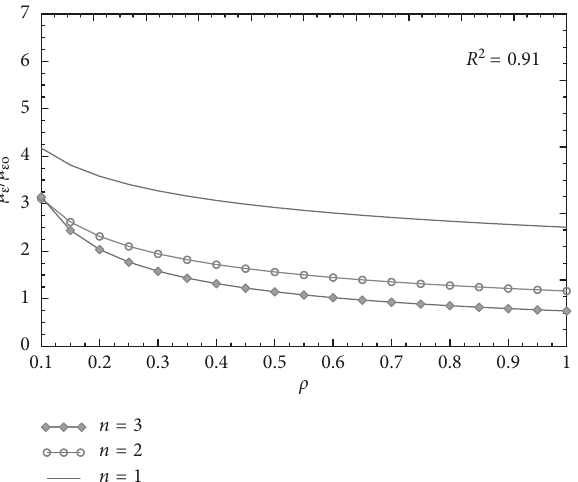
Figure 11: E / E - ρ curves of columns confined by the FRP system o for n � 1, n � 2, and n � 3.